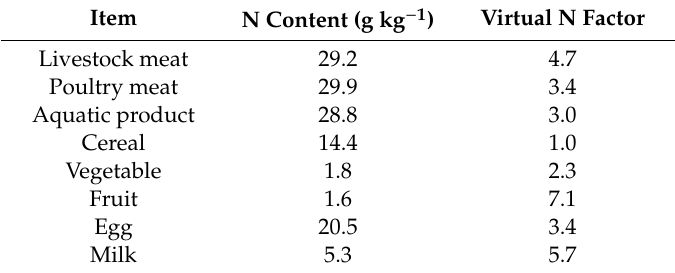
Table 1. N content and the virtual N factors in